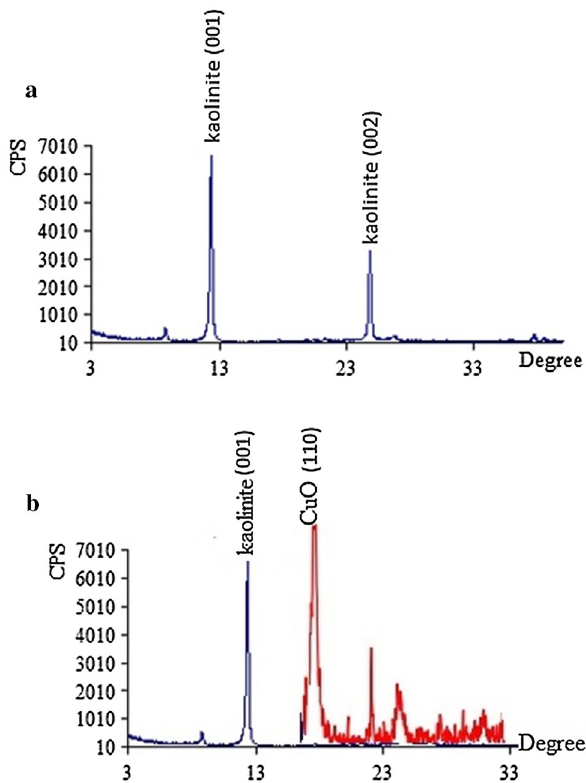
Fig. 1 a X-ray diffraction of kaolinite (Egirani et al. 2017a), b X-ray diffraction of synthetic copper oxide–kaolinite showing peaks